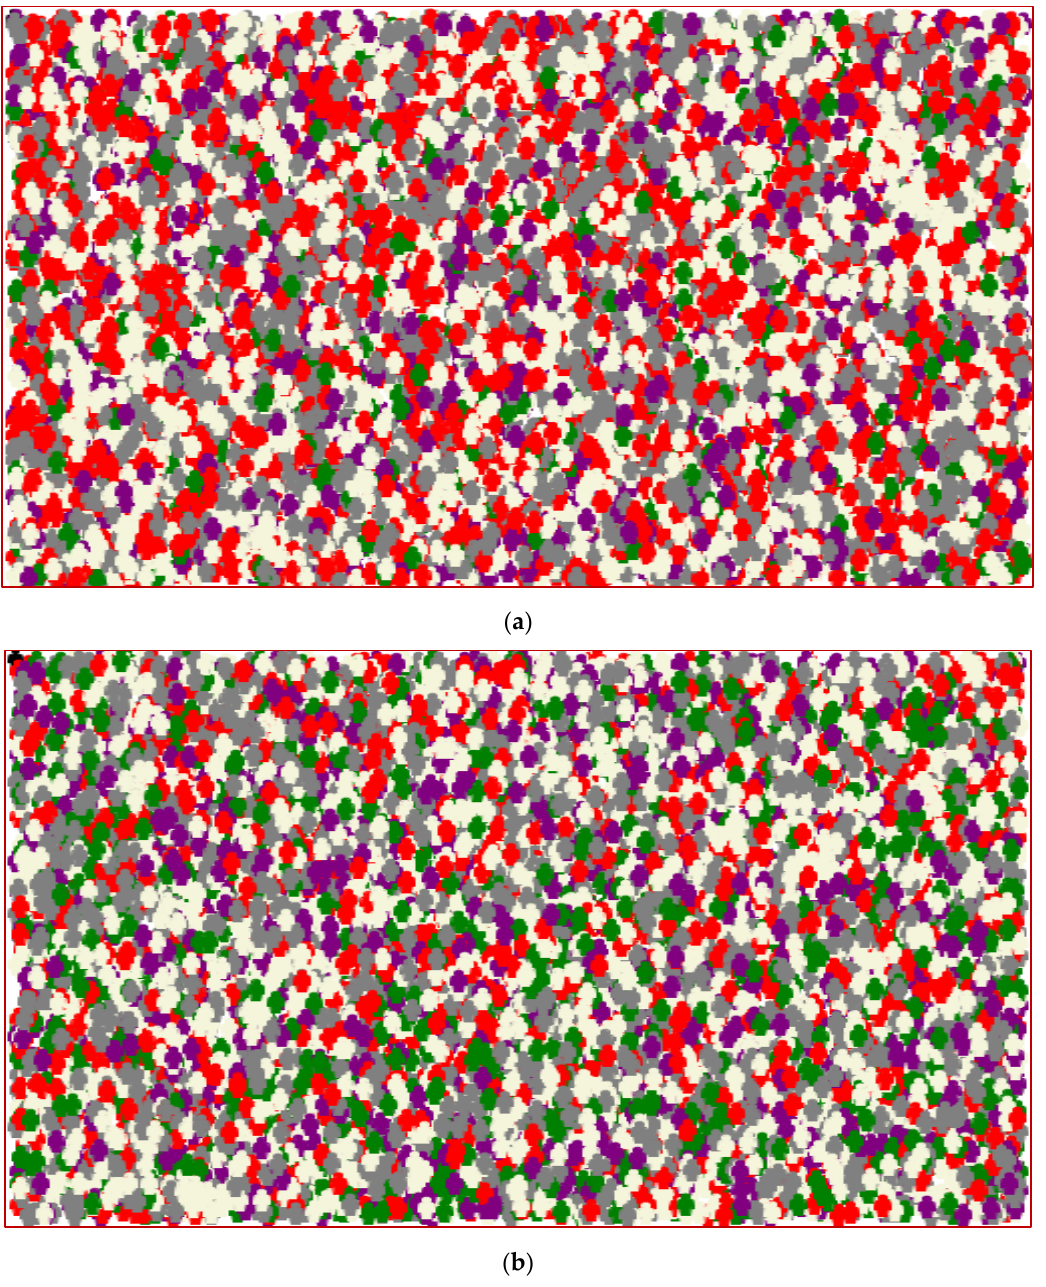
Figure 5. Population dispersion for 10,000 agents. ( a ) With little or no use of social media analytics and ( b ) with increasing usage of social media analytics.